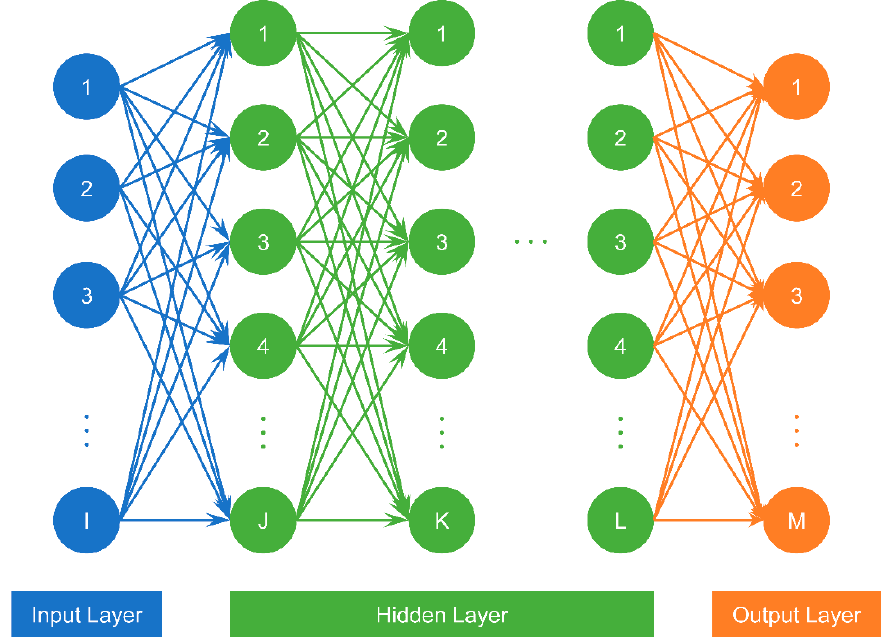
Figure 4. Deep neural network.